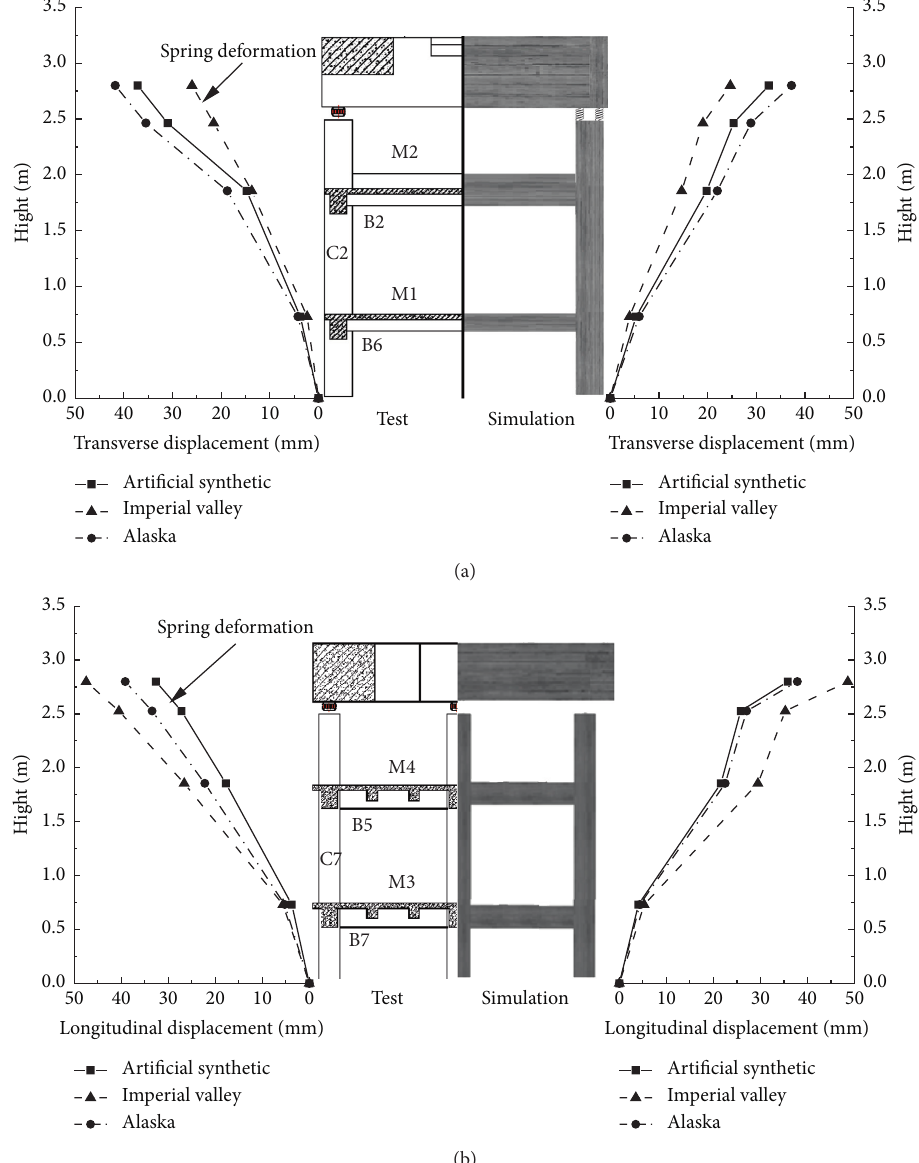
Figure 14: Displacement response contrast of different location. (a) Transverse loading. (b) Longitudinal